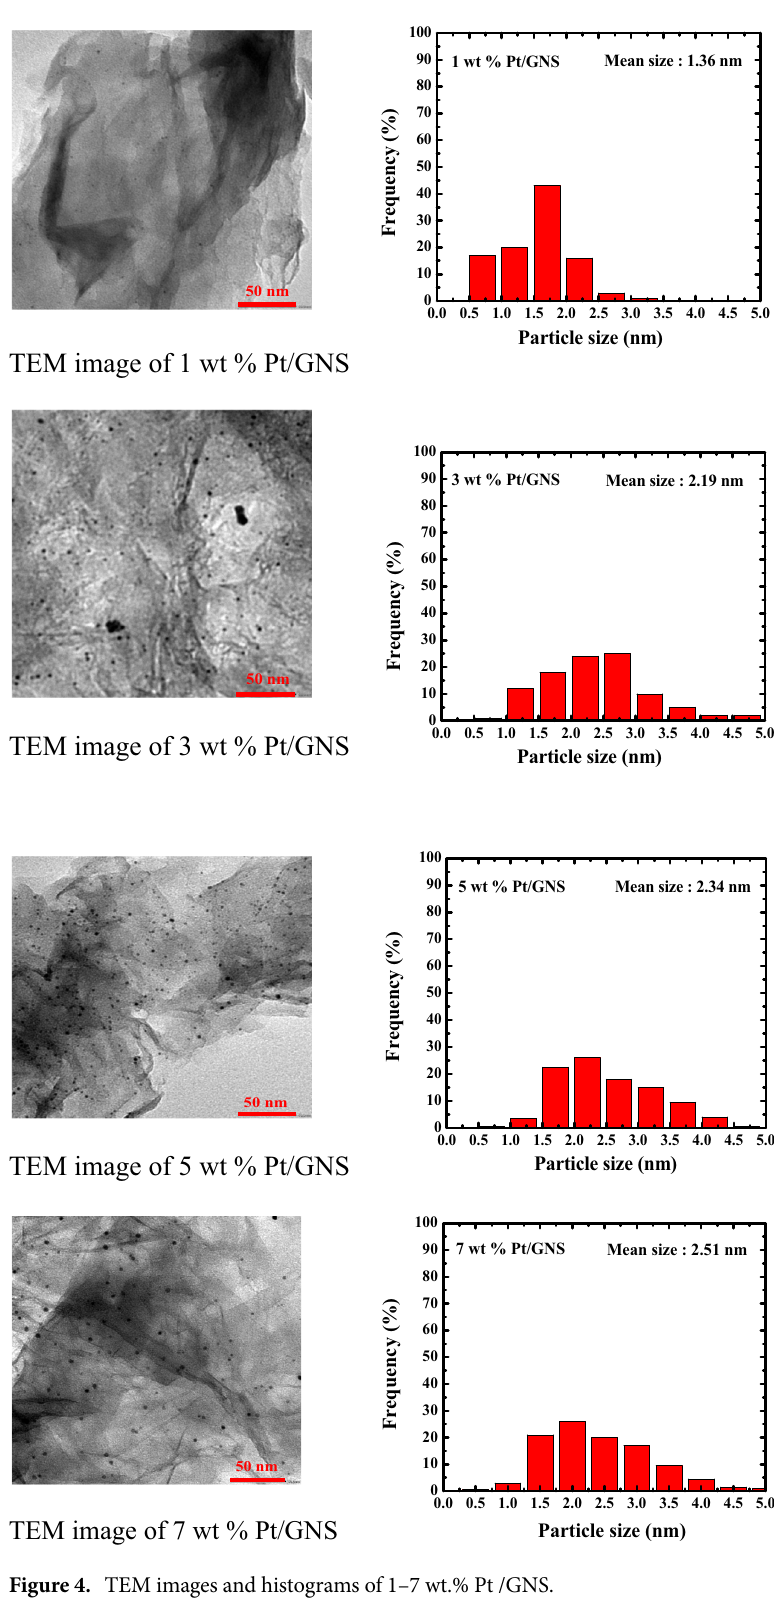
Figure 4. TEM images and histograms of 1–7 wt.% Pt